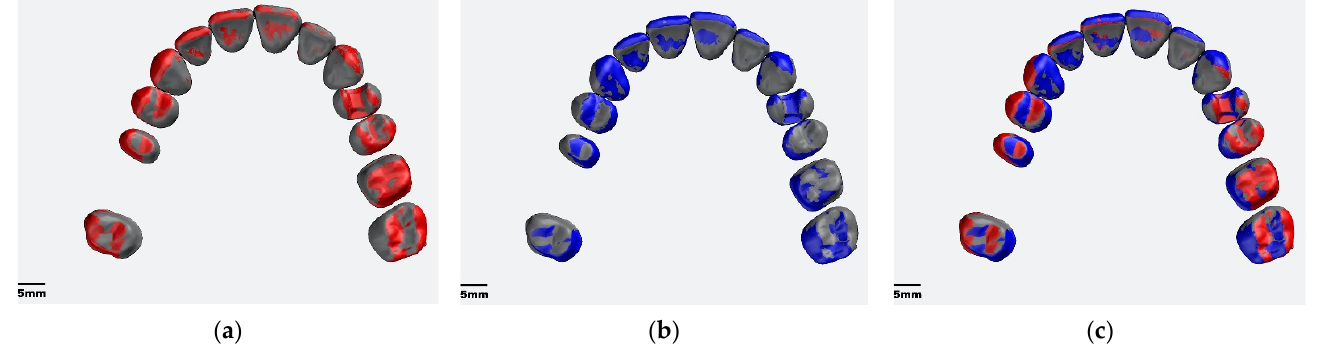
Figure 5. Compensation of the arch widening during the entire workflow: ( a ) [REF]-[IOS] (grey = REF; red = IOS). In the [IOS], the arch is widened in relation to the reference cast; ( b ) [REF]-[PRINT] (grey = ref; blue = printed). The printed cast exhibits a narrower arch than the original; ( c ) superim- position [REF]-[IOS] and [REF]-[PRINT]. The “widening” by the intraoral scan is overcompensated by the printed cast.